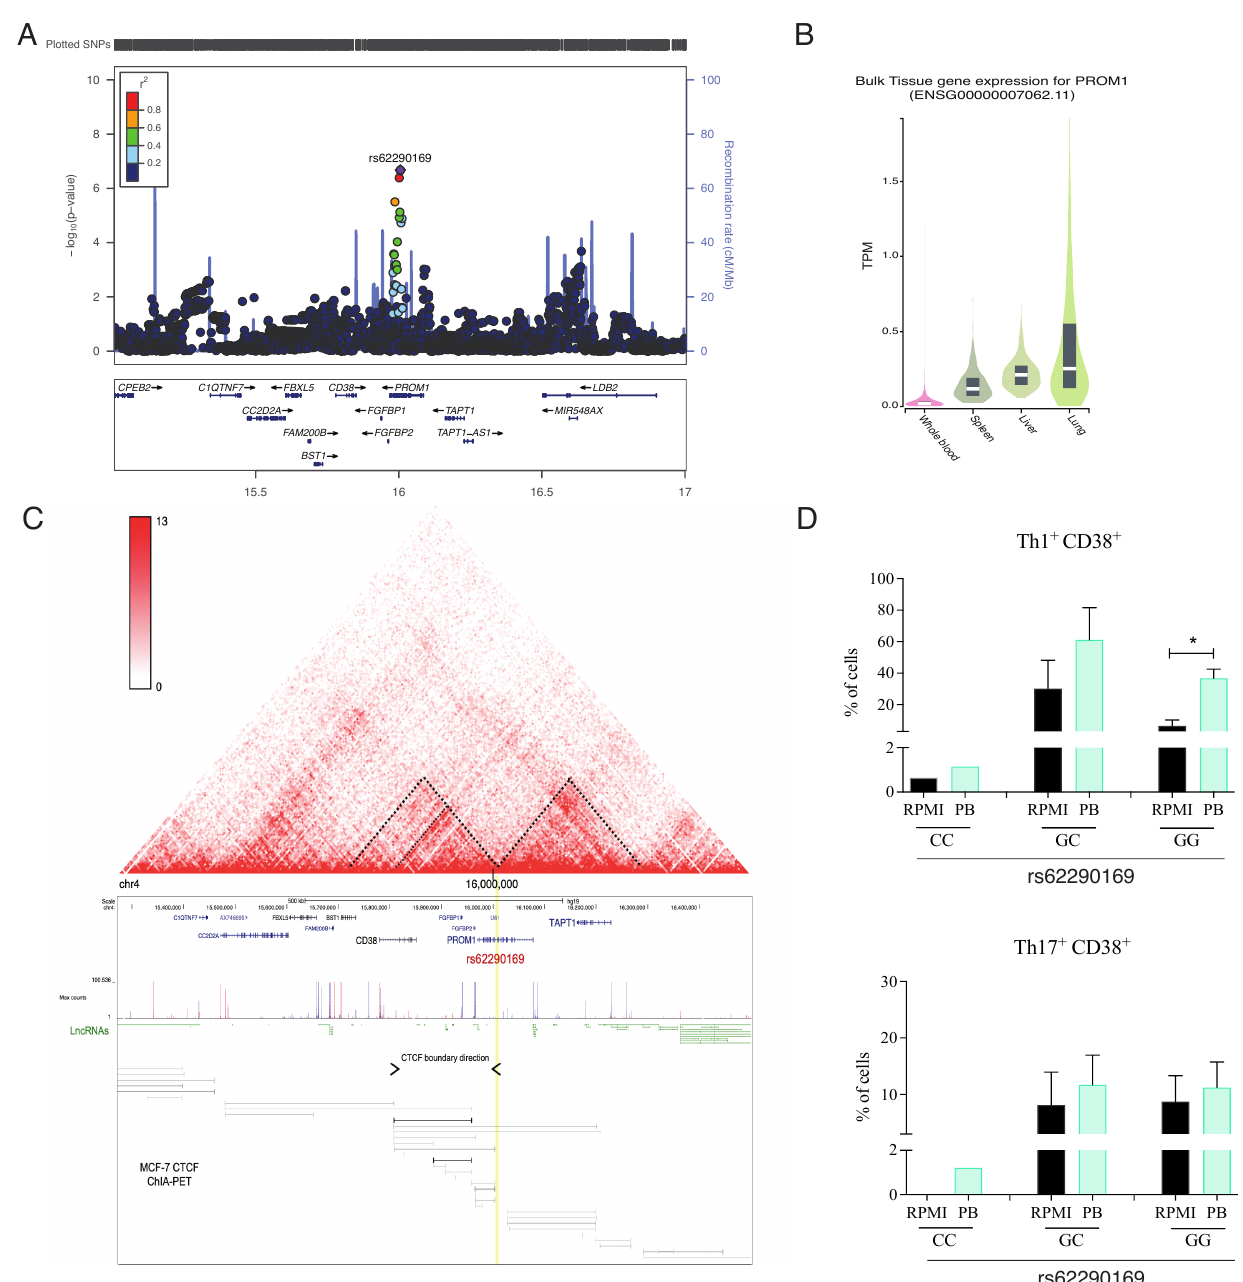
Figure 4. Regional association plot for IL22 QTL and regulation of Paracoccidioides brasiliensis -induced CD38 expression by PROM1 gene. ( A ) The regional association plot for the IL-22 production- associated SNP, rs62290169 (purple diamond), which is located at the intronic region of the PROM1 gene at chromosome 4. Each dot represents an SNP, and the linkage disequilibrium of neighboring SNPs with the top SNP is color-indicated. The y -axis represents –log10 p values of SNPs. The x -axis shows chromosome 5 positions. ( B ) GTEX expression data obtained from different tissues (www.gtexportal.org accessed on 24 March 2023). ( C ) Topologically associating domains (TADs) of PROM1 locus. ( D ) CD38 protein expression upon 7 days P. brasiliensis exposure assessed by flow cytometry in Th1, and Th17 cells of individuals part of the 200 FG cohort carrying the different genotypes of the rs62290169 SNP ( PROM1 gene) CC (n = 1), GC (n = 4), GG (n = 6) (Wilcoxon paired test, * p <